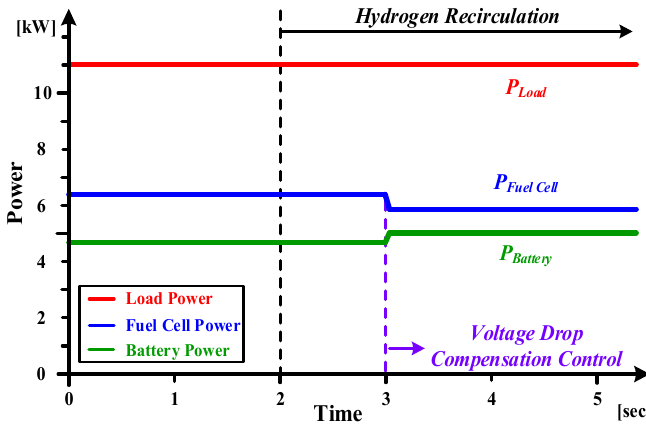
Figure 9. Output power waveforms of load, fuel cell and battery.